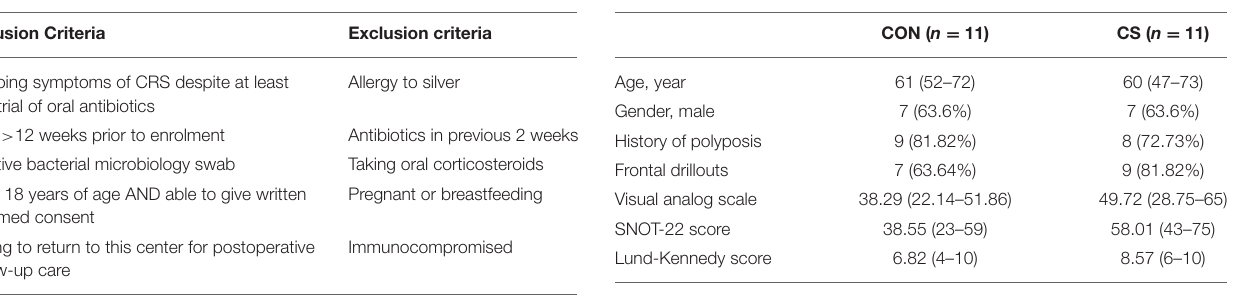
TABLE 1 | Inclusion and exclusion criteria. TABLE 2 | Baseline patient demographics and clinical